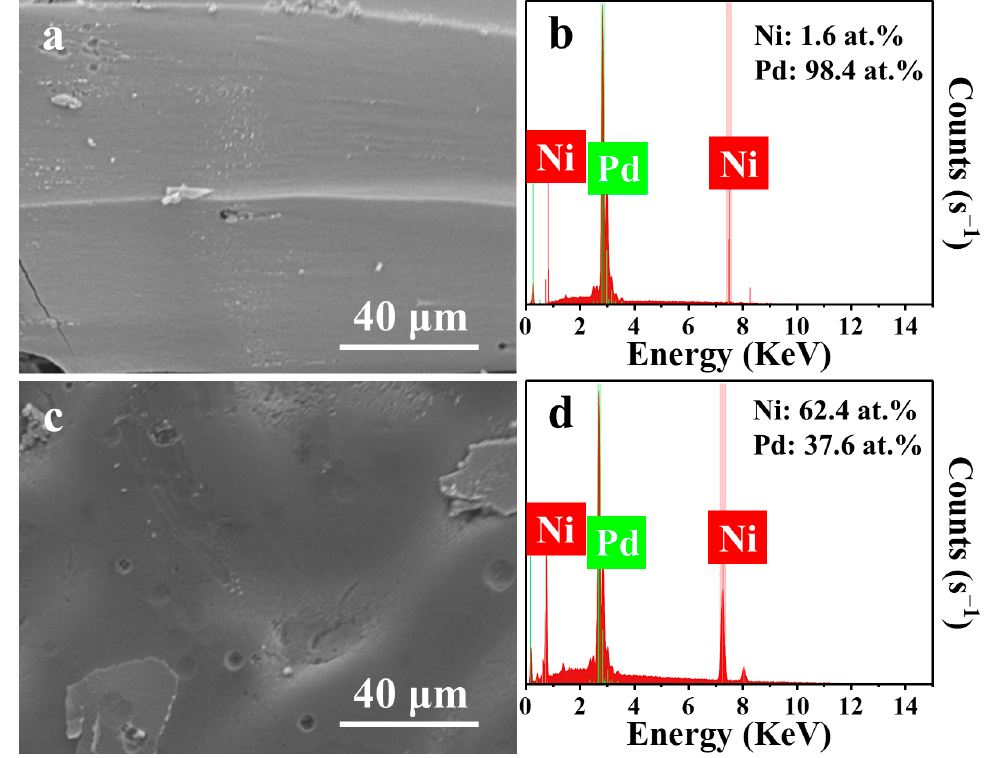
Figure 6. The SEM images and corresponding EDS spectra of ( a , b ) the region near the external surface and ( c , d ) the center of the sample after dealloying at 0.5 V vs. Ag/AgCl. The average chemical compositions are shown in the corresponding EDS spectrum as an inset.